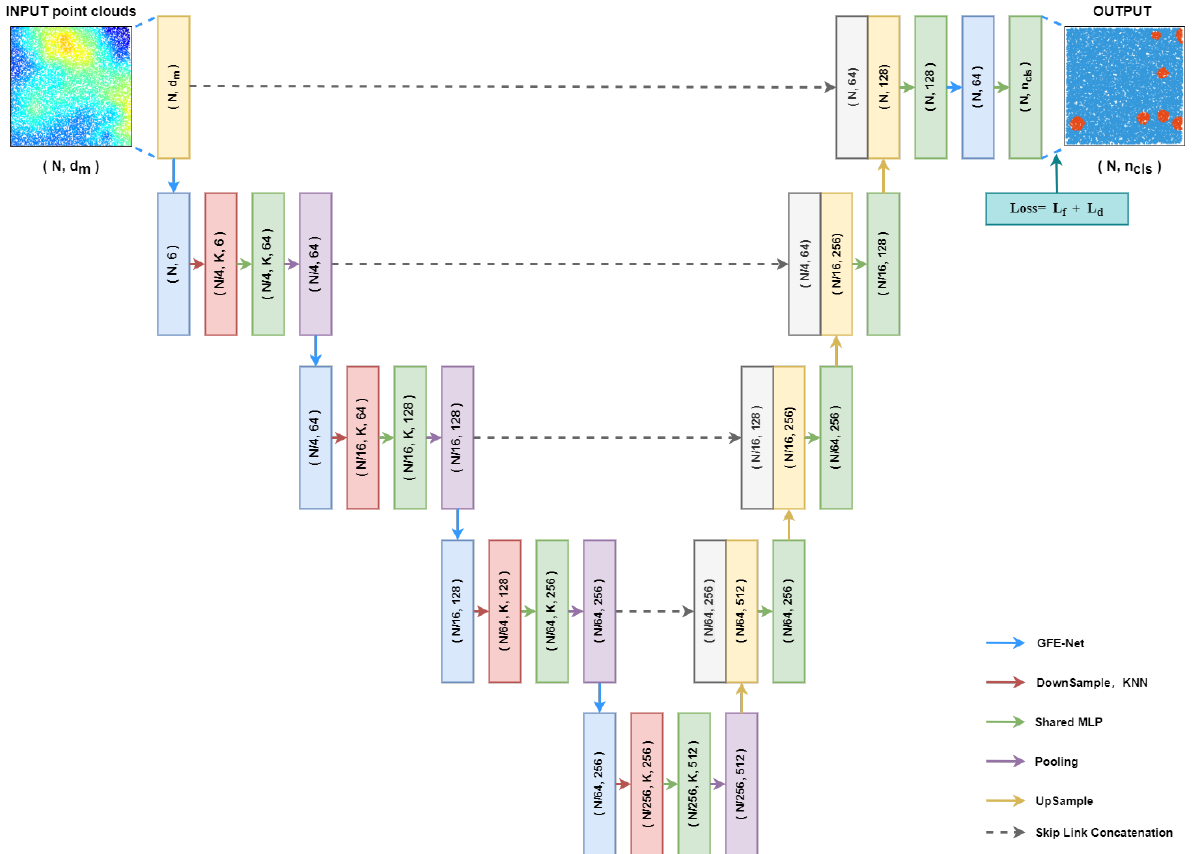
Figure 5. The overall architecture of the proposed network. The colored arrows represent the different operations, and the boxes with the same color as the arrows represent the results of the corresponding operations. The network receives N × d m point cloud as input, and the final output is N × n cls . Where, n cls represents the number of categories. The cyan box represents the loss function we used, L f is the Focal loss and L d is the Dice